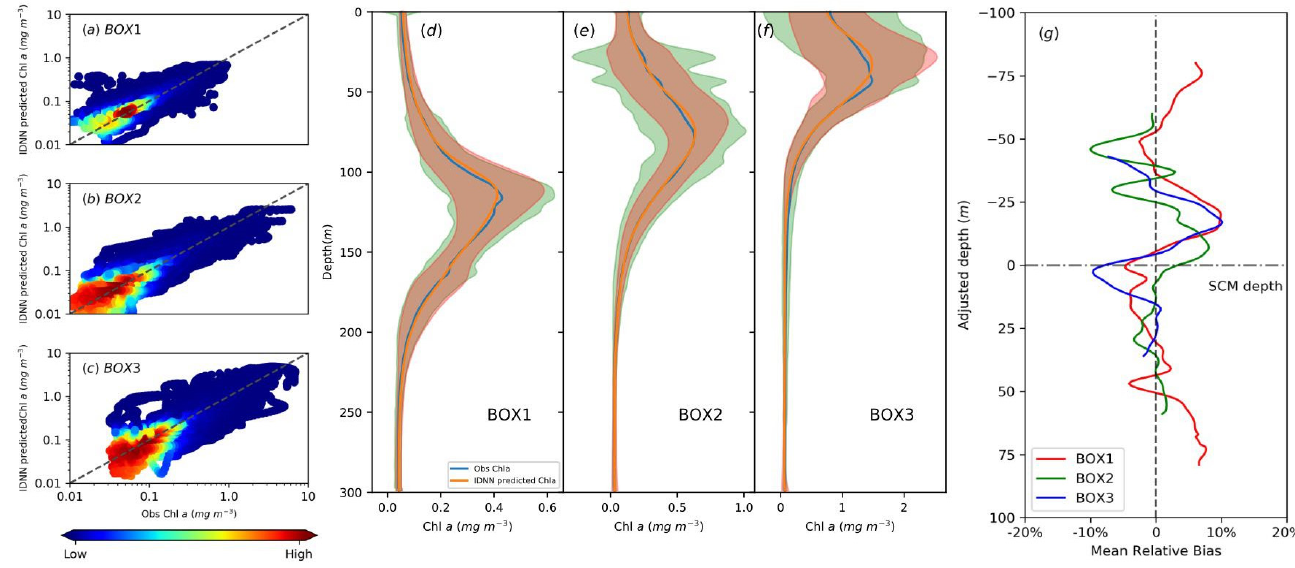
Figure 4. ( a – c ) Scatter plot of observed Chl a concentration ( x -axis) and estimated Chl a value ( y -axis) in BGC-Argo test set in BOXes 1 – 3. The black dashed line is the bisector of the first quadrant, i.e., y = x. ( d – f ) The mean of observed value (blue line) and the mean of IDNN predicted values (orange line) in each BOX. The pink and green shades are the standard variance of the model results and observations, respectively, which overlap and form the brown shade. ( g ) The mean relative bias as a function of the adjusted depth between observed and the IDNN predicted Chl a in the test set for the three BOXes. The adjusted depth is defined as the difference between the observed SCM depth and the modeled